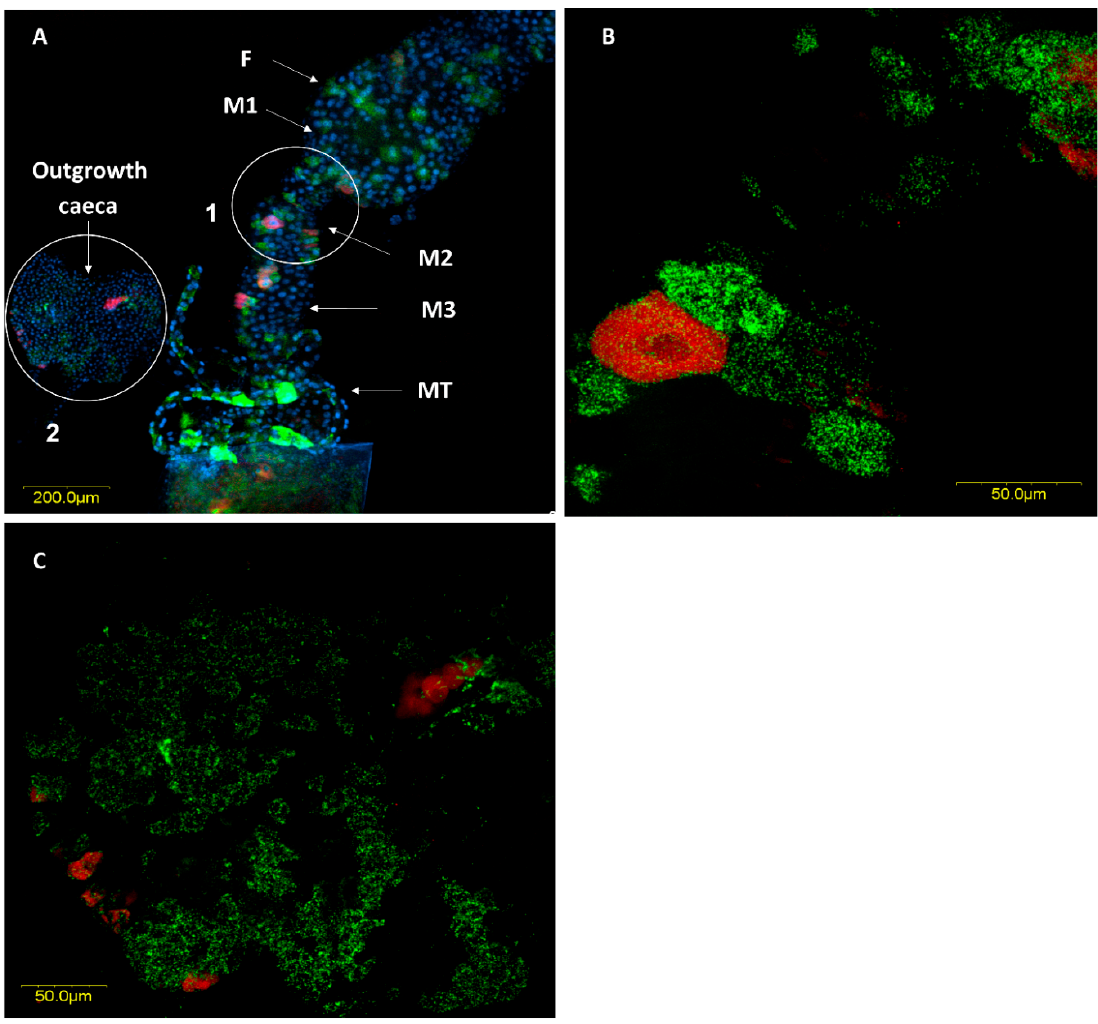
Figure 6. FISH of the male M. pygmaeus digestive system (DNA in blue). ( A ) The digestive system, R. belli i (red), R. limoniae (green), with two outgrowth caeca from the gut tissue of the third midgut section dissected aside (see circle 2). ( B ) Enlarged section from the midgut (see circle 1). ( C ) Enlarged section of the two outgrowth caeca (see circle 2). Images A, B and C represent serial Z sections of 35 µm, 8.8 µm, 37.7 µm respectively. F, foregut; M1, midgut first section; M2, midgut second section; M3, midgut third section; MT, Malpighian tubules.